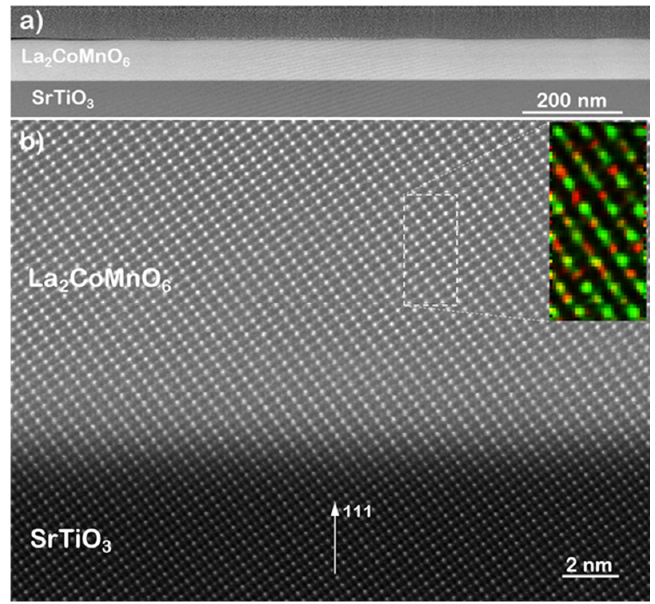
Figure 10. ( a ) High Angle Annular Dark Field (HAADF) image of the La 2 CoMnO 6 L3 sample; ( b ) a high resolution HAADF image of LCMO/STO interface; the Mn (green)/Co(red) cation ordering in the dash-marked area is shown in the inset.